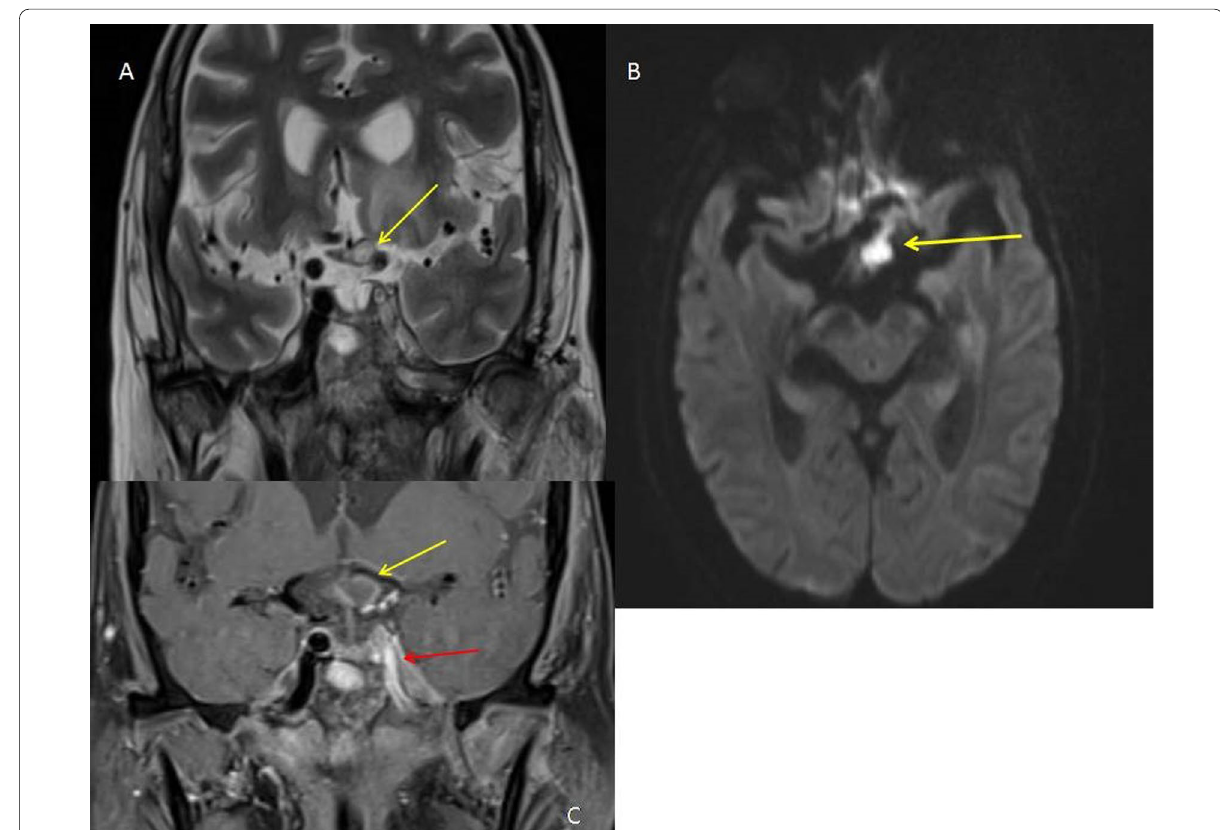
Fig. 5 A STIR coronal sequence demonstrating hyperintense residual disease (arrow) in the left half of optic chiasma. B Axial diffusion-weighted sequence demonstrating diffusion restriction in the left half of optic chiasma. C T1 post-contrast coronal sequence showing peripheral contrast enhancement (yellow arrow) in the left optic nerve. Also noted is the loss of flow void (red arrow) of the cavernous portion of the left ICA, suggestive of